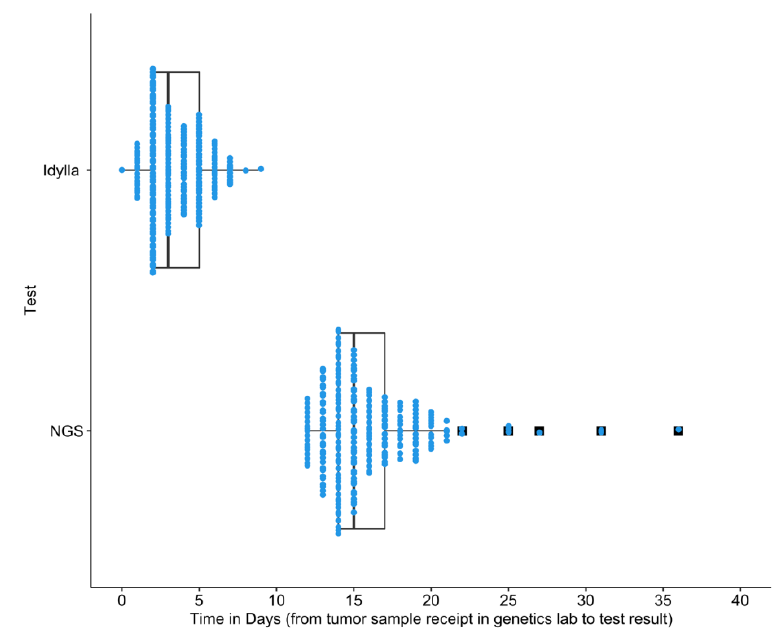
Figure 1. Comparison of laboratory TAT between the Idylla EGFR and Oncopanel NGS in patients who received concurrent Idylla and Oncopanel testing (N = 235). Each blue dot represents an individual at a certain time-point. Boxplots visualize median, two hinges (25% and 75% quantiles), and two whiskers (95% CI). Black squares indicate outliers. The difference in means was −12.4 days ( p < 0.0001, 95% CI: [−12.8, −11.9] days). The mean lab TATs are 15.8 and 3.4 days for the Oncopanel and Idylla EGFR test, respectively.